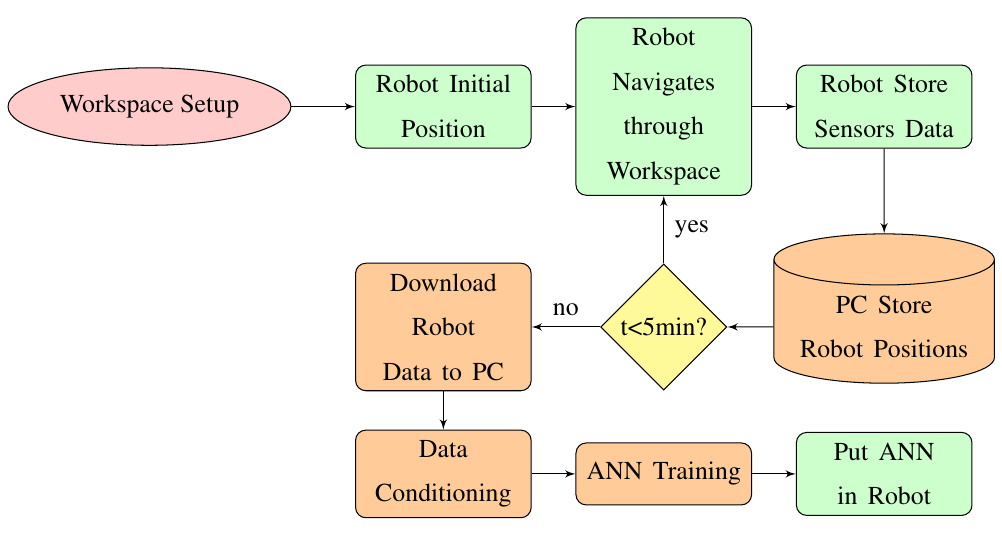
Figure 14. Flow diagram of the developed calibration